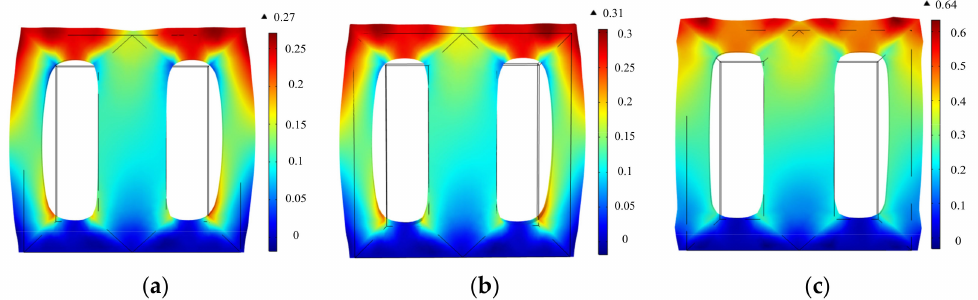
Figure 12. Displacement distributions of the laminated core: ( a ) Sinusoidal excitation ( B 1 = 0.8 T); ( b ) the fifth harmonic accounts for 50% of the fundamental component in the hybrid harmonic excitation ( B 1 = 0.8 T, B 5 = 0.4 T); ( c ) DC bias of 1A ( B 1 = 0.8 T, H dc = 76 A / m).